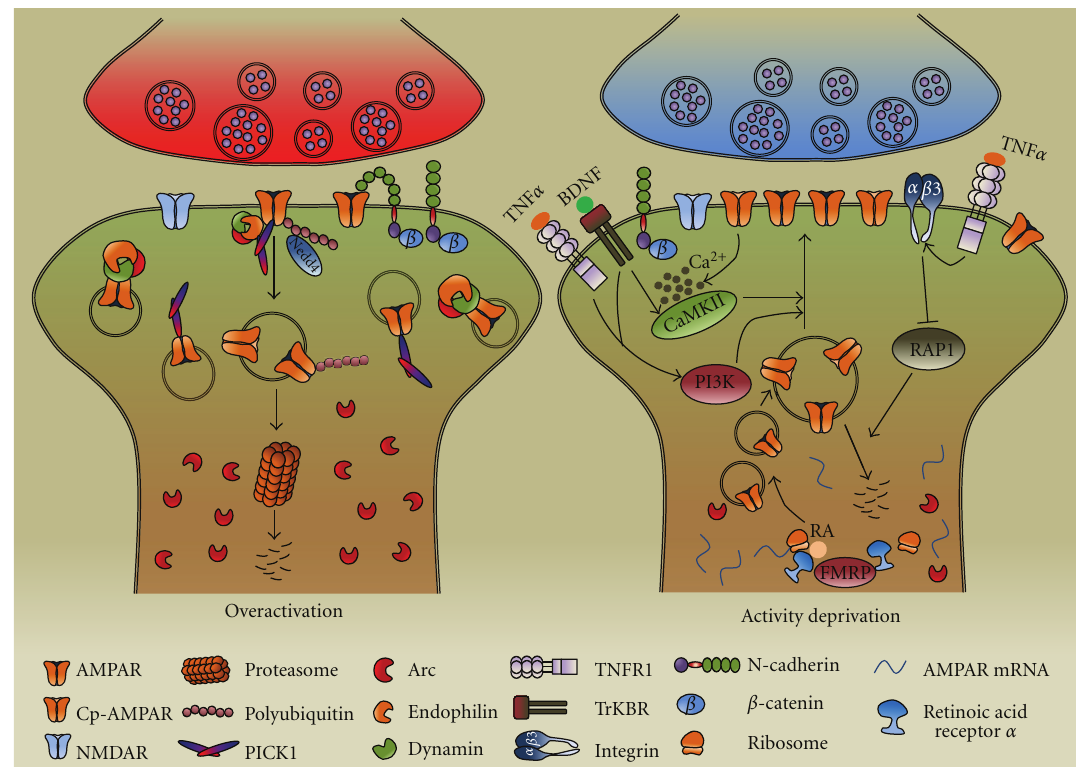
Figure 3: Regulation of homeostatic AMPAR tra ffi cking and turnover. Multiple functional molecules and signaling cascades are involved in the homeostatic up- or downregulation induced by prolonged activitydeprivation or overactivation, respectively. Elevated synaptic activation stimulates the expression of an immediate-early gene product, Arc, which, together with endophilin and dynamin, promotes AMPAR internalization. This process also requires the association of AMPARs with PICK1, and Nedd4-mediated receptor ubiquitination and proteasomal degradation (left panel). Under activity deprivation, varied signaling cascades are implicated in AMPAR tra ffi cking and synaptic localization. Activation of TNFR1 by glia-derived TNF α , or PI3K pathway by BDNF/TrKBR and TNFR1 signaling, significantly enhances the postsynaptic AMPAR levels. β 3 integrin signaling inhibits the activity of RAP1, which is known to enhance AMPAR degradation. Also, calcium influx through the inactivity-induced GluA2-lacking AMPARs (Cp-AMPAR) activates the CaMKII pathway, causing AMPAR phosphorylation and insertion. In addition, retinoic acid receptor α (RAR α ) and FMRP mediate AMPAR local synthesis in postsynaptic domain during activity deprivation-induced upscaling (right